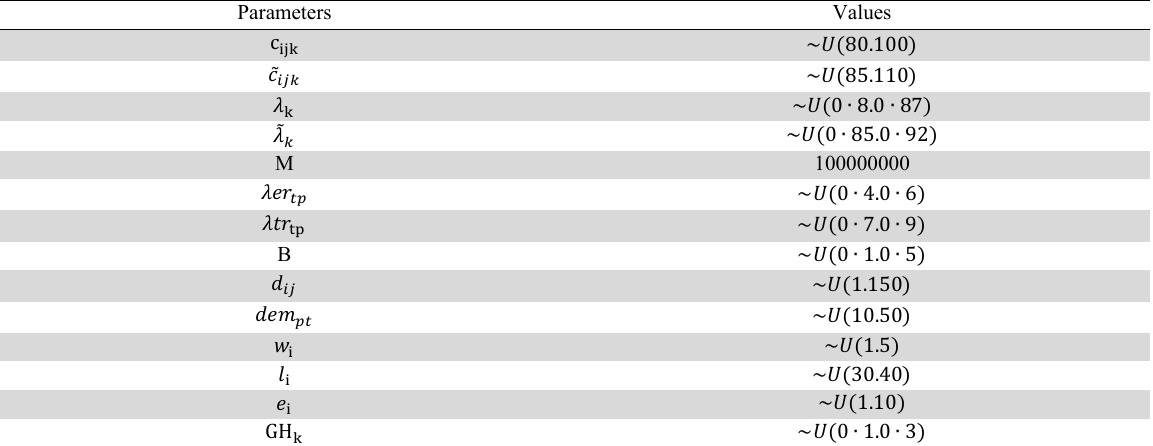
Source of randomly generated parameters